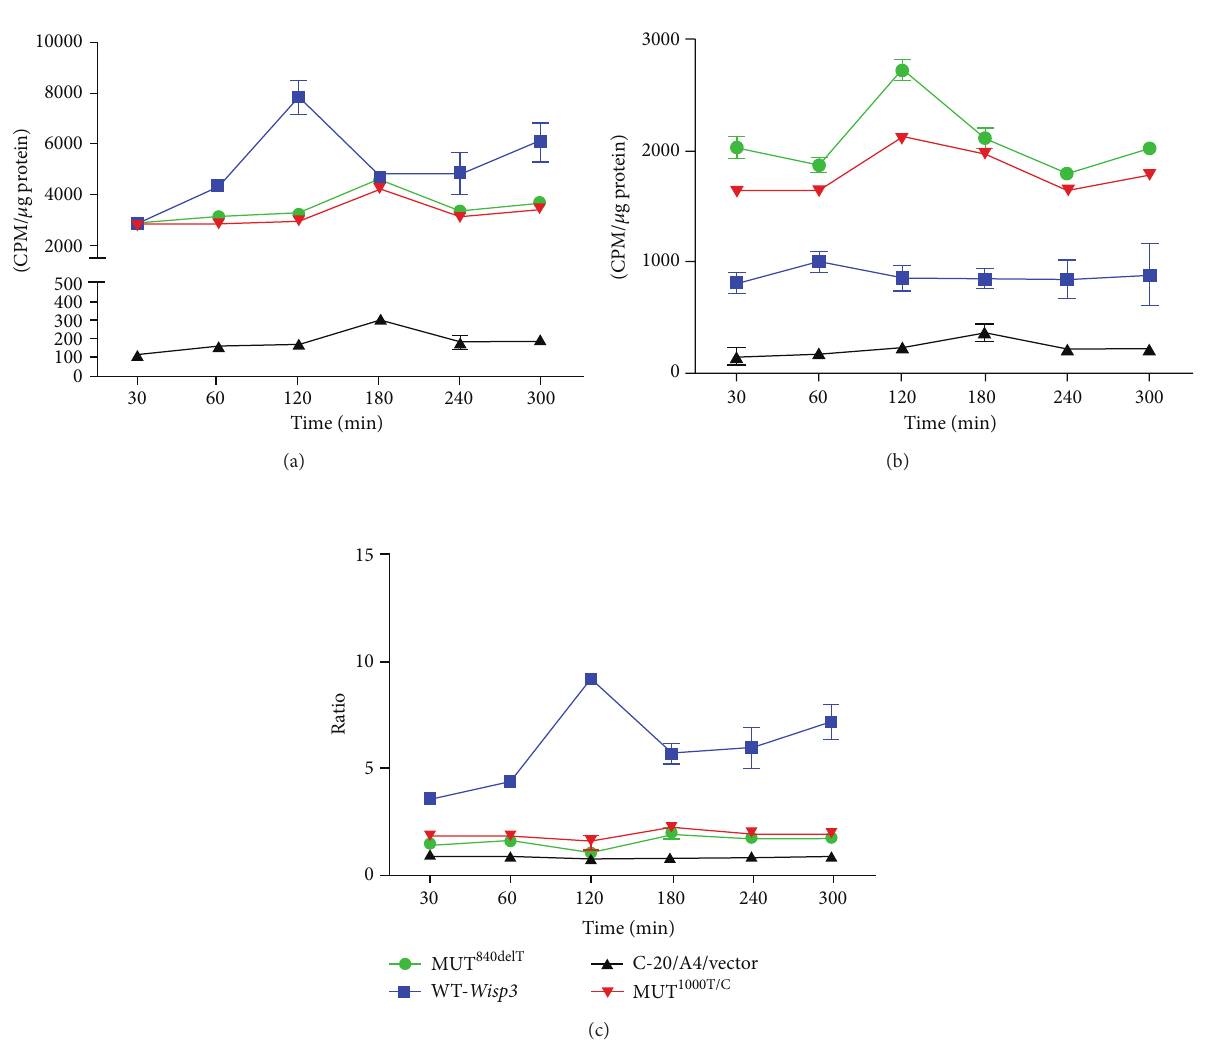
Figure 6: Change of intracellular collagen content and extracellular collagen secretion in mutant chondrocytes analyzed by 14 C-proline incorporation assay. (a) Time course of 14 C-proline labeled collagen (detected by radioactivity) secreted to the supernatant of the cultured chondrocytes. (b) Time course of 14 C-proline labeled collagen content in cultured chondrocytes. (c) Ratio of secreted collagen to intracellular